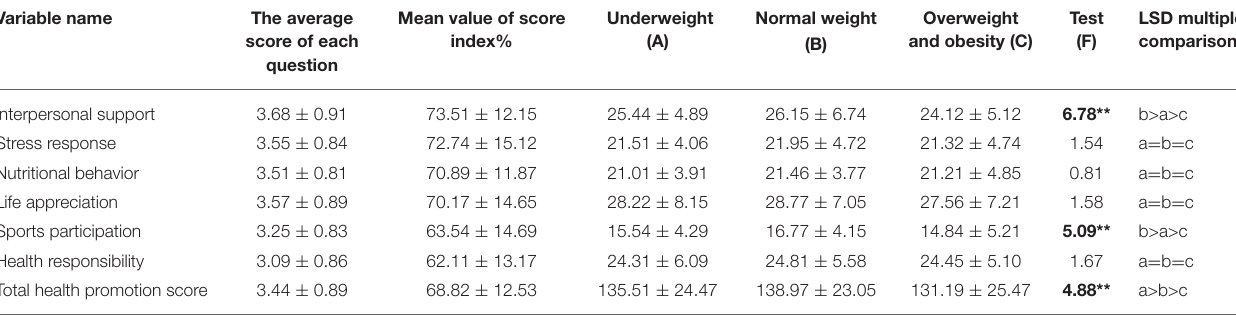
LSD multiple comparisons